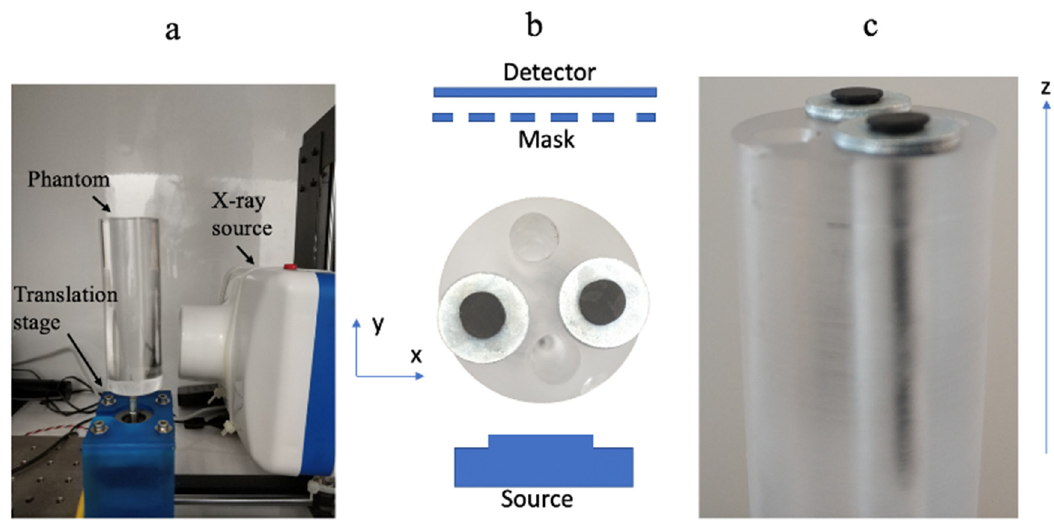
Figure 3. ( a ) The experimental setup: the source, and the phantom are shown. ( b ) Schematic sketch of the experimental configuration with the flat panel detector and the coding mask. ( c ) The object included two metallic nails in the cylindric polymer.